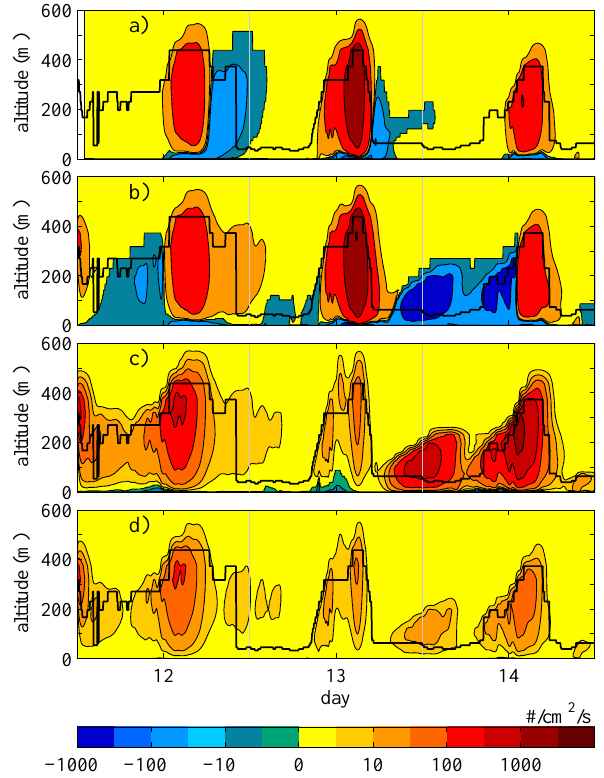
Fig. 5. Turbulent particle flux (cm − 2 s − 1 ) for (a) 3–6nm (b) 3– 25nm, (c) 25–100nm and (d) 100–1000nm particles. Black solid curve represents simulated mixing